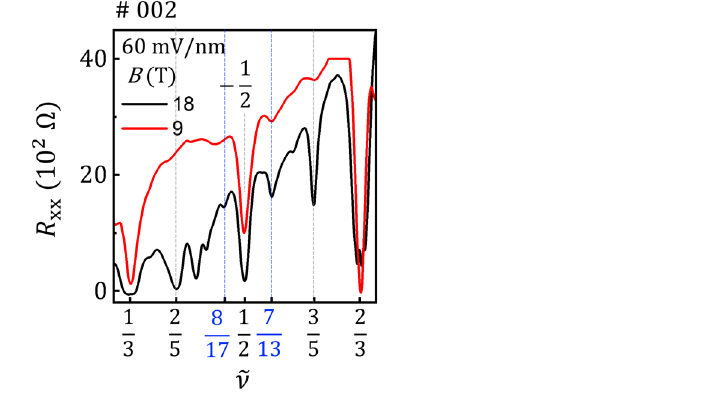
FIG. 3. Revised Fig. 3(d) with data plotted using ˜ ν ¼ ν − ½ ν (cid:2) , where ½ ν (cid:2) ¼ − 1 for ν ¼ − 1 = 2 .